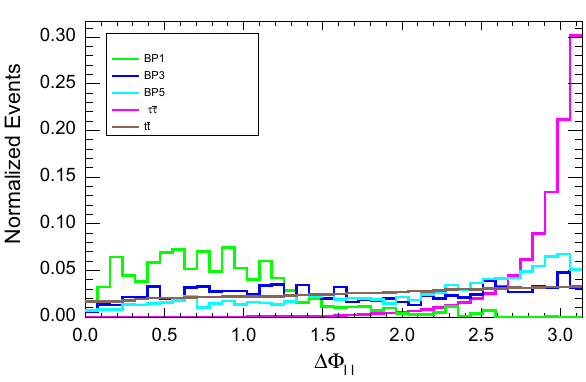
Fig. 7 Distribution of collinear mass (left) and transverse mass (right) for signal and backgrounds